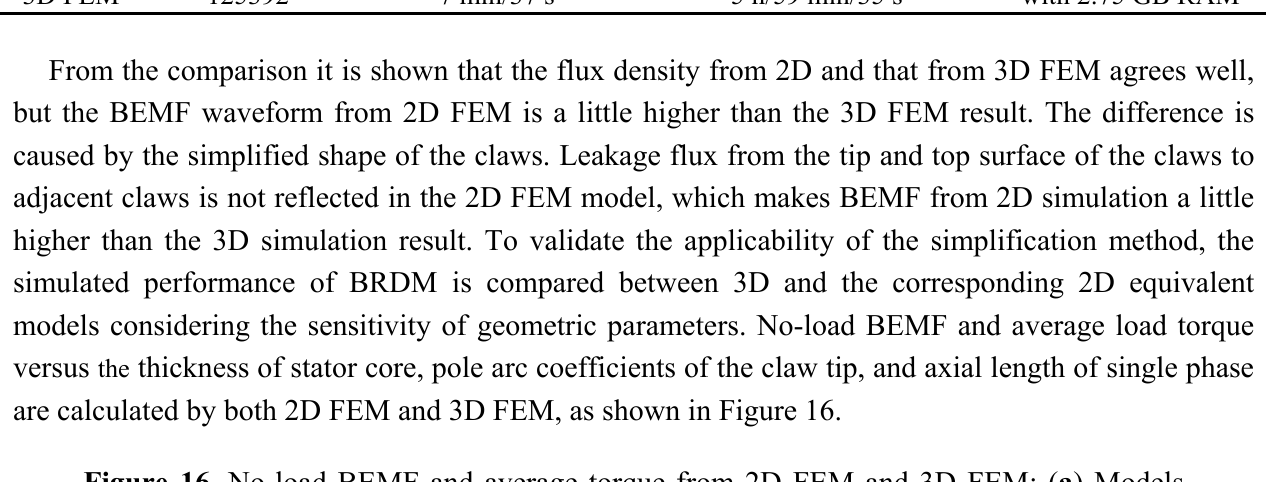
Figure 16. No-load BEMF and average torque from 2D FEM and 3D FEM: ( a ) Models with different pole arc coefficients of the claw tip; ( b ) Models with different axial lengths of single-phase; ( c ) Models with different thickness of stator